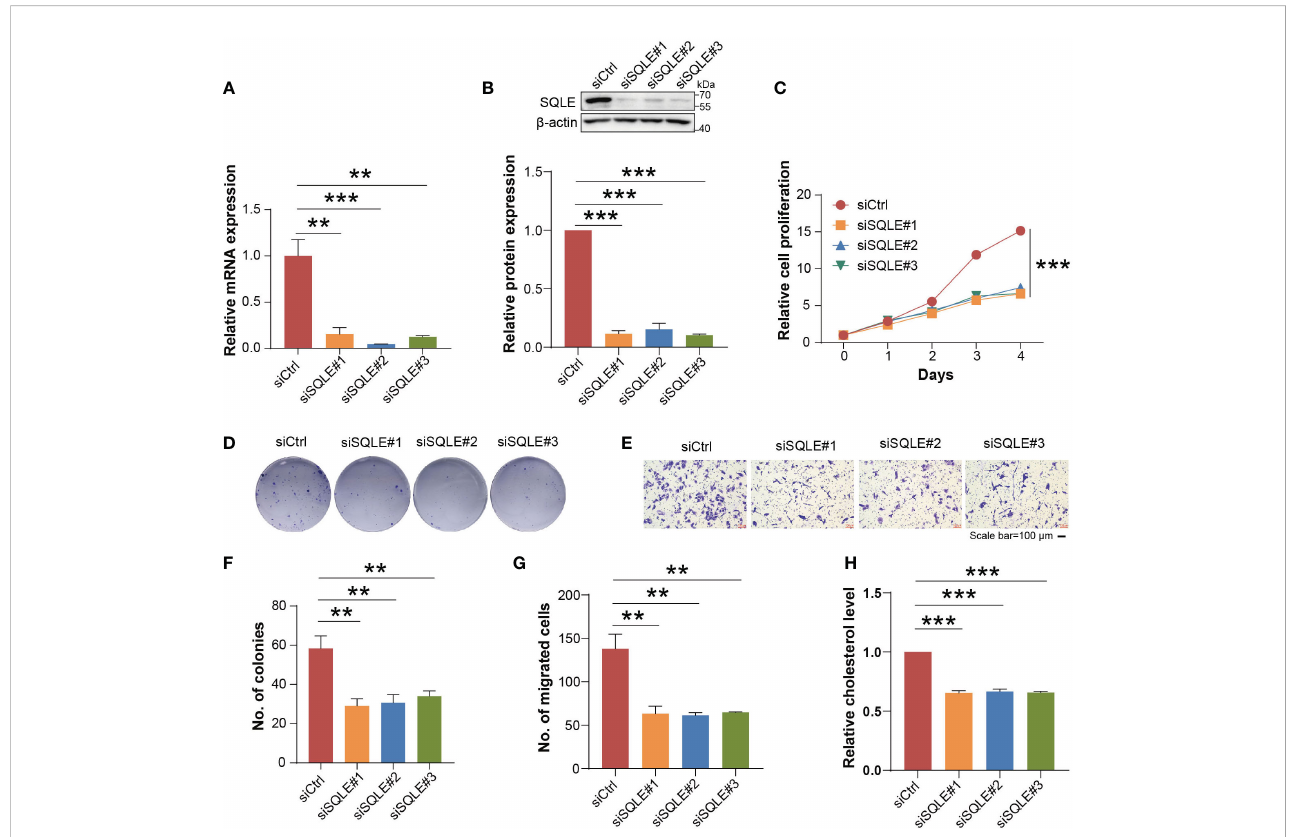
FIGURE 5 SQLE knockdown produced signi fi cant inhibition on cancer-related phenotypes of U2OS cells in vitro . (A) Quantitative PCR (Q − PCR) with mRNA expression con fi rmed the knockdown of SQLE after 24h siRNA transfection. (B) Western blot analyses with protein expression con fi rmed the knockdown of SQLE after 48h siRNA transfection. The b -actin was treated as the loading control. (C) Cell proliferation was suppressed by SQLE knockdown. (D) Cell colony formation ability was reduced by SQLE knockdown. (E) Cell migration was inhibited by SQLE knockdown. The scale bar represented 100 m m. (F) and (G) indicated the quanti fi cation of positive signals from (D, E) , respectively. (H) The knockdown of SQLE signi fi cantly reduced the intracellular cholesterol. Error bars represented ± SD of three biological replicates. **P < 0.01, ***P < 0.001 by Student